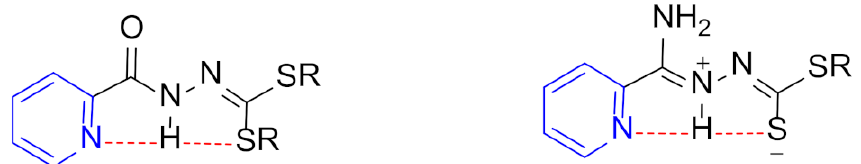
Figure 1. Intramolecular hydrogen bonds formed in the molecules of S , S -diesters of picolinoylcar- bonohydrazodithioic acid and amino(pyridin-2-yl)methylenecarbonohydrazodithioic acid.